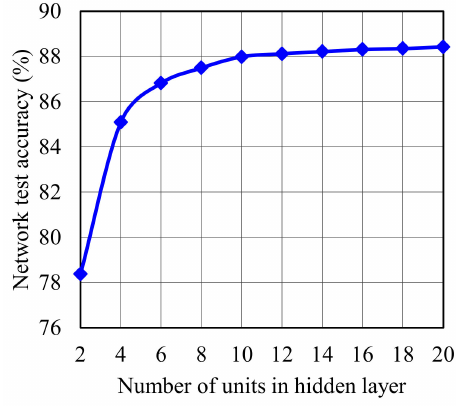
Figure 9. Network size against network